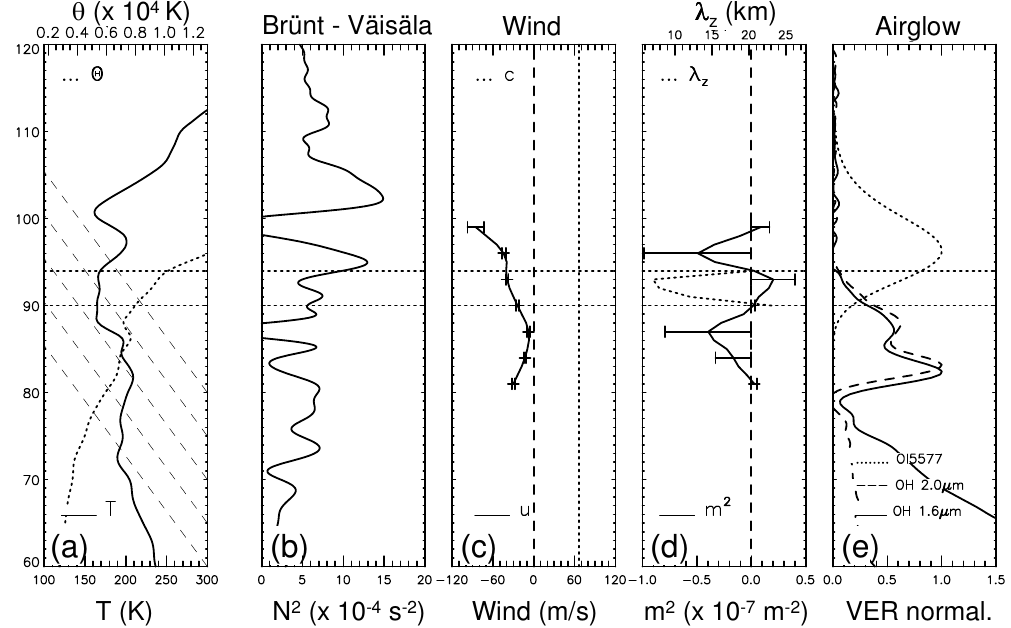
Fig. 2. (a) Kinetic temperature profile (solid line) obtained by the TIMED/SABER satellite on 1 October 2005, over S˜ao Jo˜ao do Cariri and potential temperature profile (dotted line). The dashed lines represent the adiabatic lapse rate. (b) Square of Br¨unt-V¨ais¨al¨a frequency profile. (c) Wind profile in the same propagation direction as the wave front measured at 18:00(LT) by meteor radar (solid line). The dotted line represents the wave phase velocity. (d) Vertical squared wavenumber ( m 2 ) (solid line) and vertical wavelength ( λ z ) (dotted line). (e) normalized volumetric emission rate (VER) profiles of the OH at 1.6 µ m (solid line) and OH at 2.0 µ m (dashed line) measured by the TIMED/SABER satellite, and OI5577 (dotted line) calculated using MSIS-90 atmospheric model. The horizontal solid lines in all graphs show the top and bottom of the